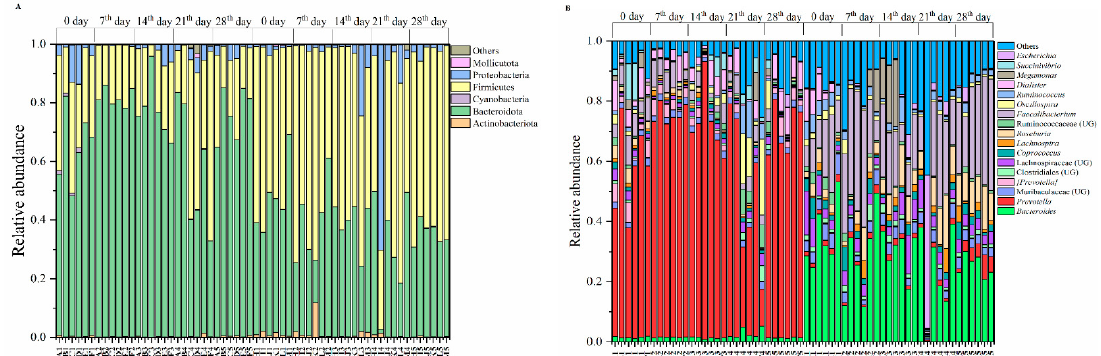
Figure 2. The composition of dominant gut microbiota in Pakistanis and Chinese at the phyla level ( A ) and genus level ( B ). The identifiers of 6 Pakistani participants are A–F, and the identifiers of 6 Chinese participants are H–M, and 1–6 represented different time point, 0 day, 7th day, 14th day, 21th day and 28th day. For example, A3 represented the Pakistanis participant marked A in 14th day.